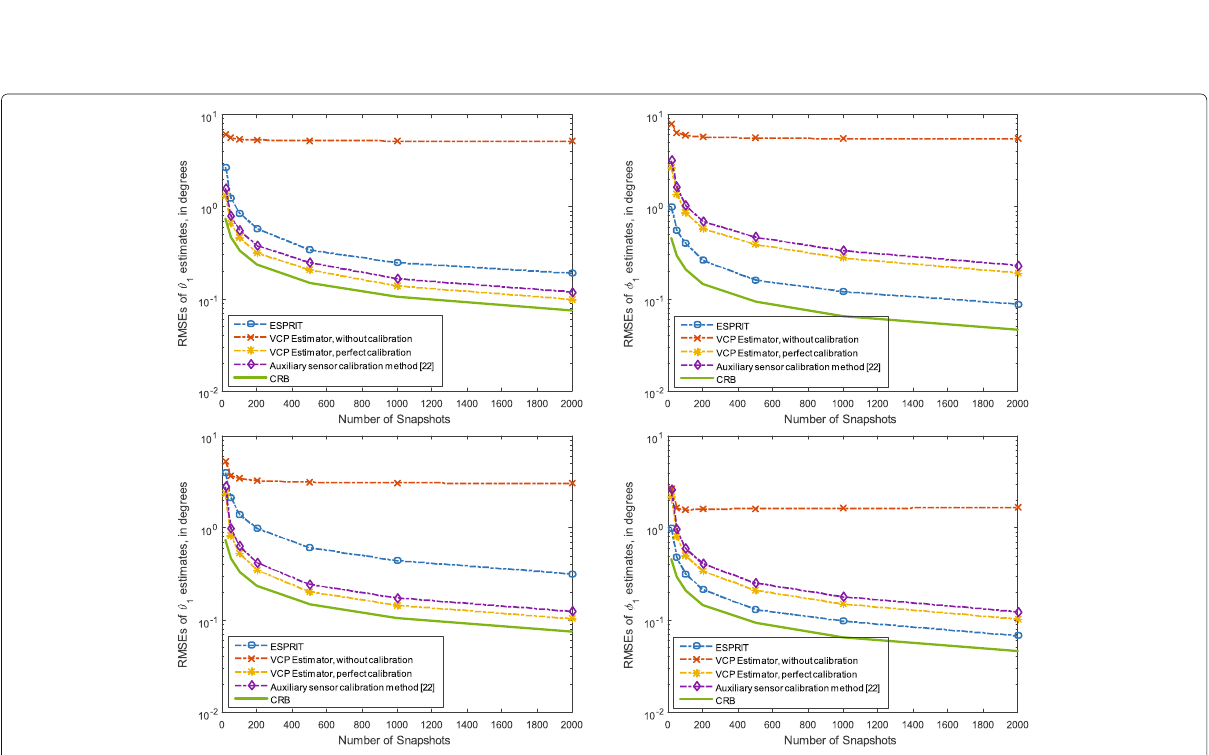
Fig. 5 RMSEs of angle estimates against snapshots. Two uncorrelated signals with θ 1 = 21.13°, φ 1 = 33.69° and θ 2 = 39.82°, φ 2 = 51.34° impinge upon a single-vector sensor. Five hundred independent experiments are